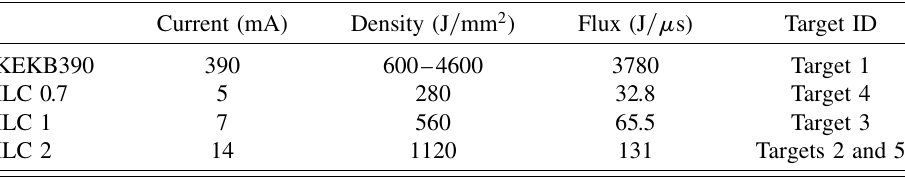
TABLE IV. Summary of the experimental menu. All of the shots were taken with a 15 mm thick W-Re block.